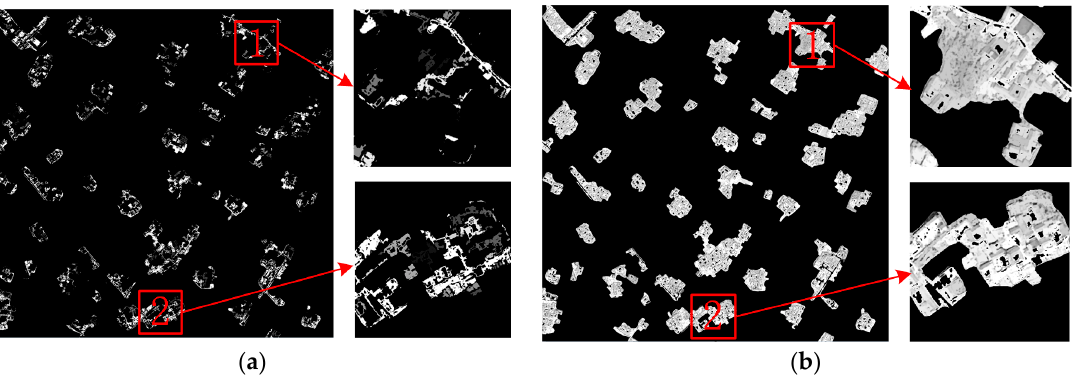
Figure 9. MBI features of two compared models: ( a ) “MBI+SR+gCRF”; and ( b ) gCRF_MBI.